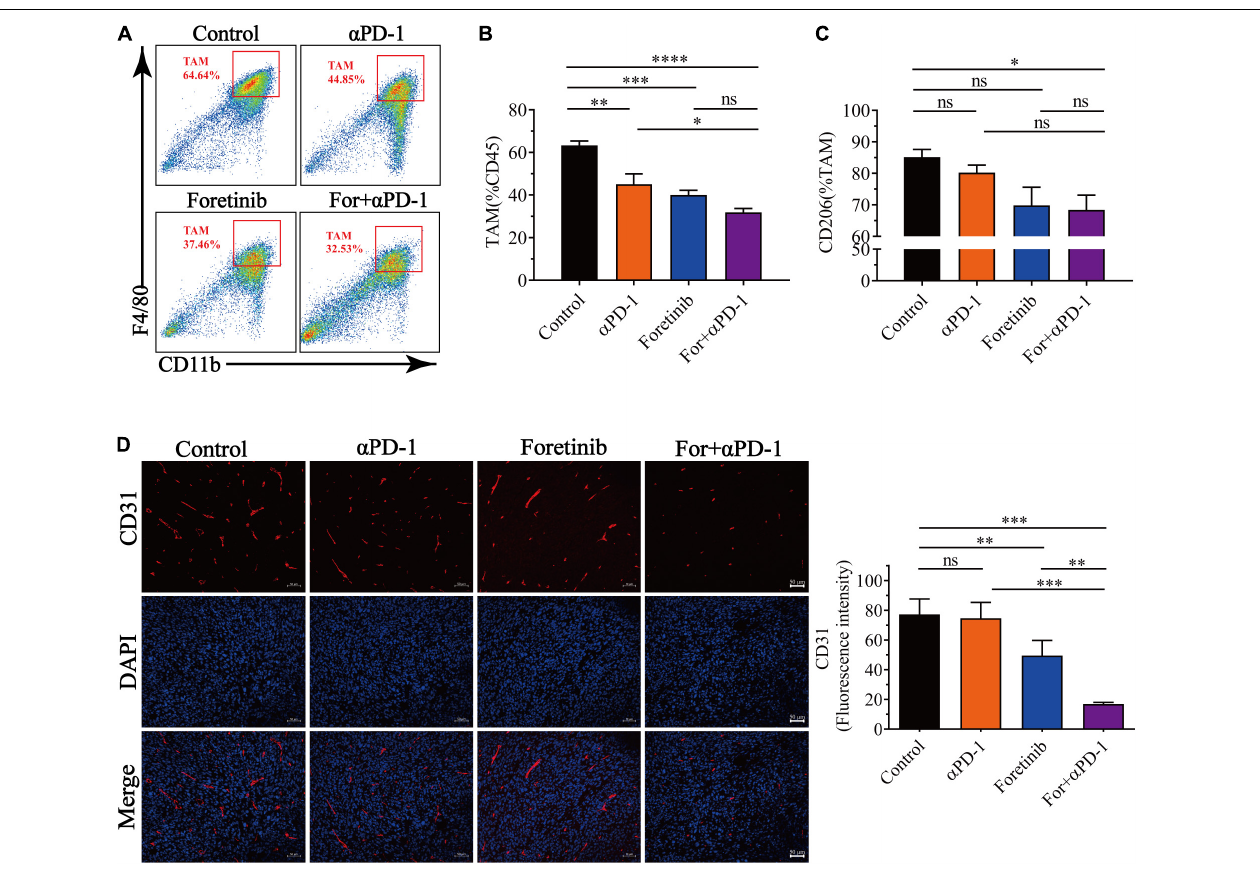
FIGURE 4 | Combination therapy decreased the number of TAM cells and inhibited angiogenesis. After finishing the treatment protocol, the tumor tissues were harvested and the TAMs and M2-type TAM infiltration was detected by FCM ( n = 6), angiogenesis (CD31+ cells) were detected by immunofluorescent ( n = 5). (A) Representative images of the gating strategy to defined TAMs. TAMs were characterized as being CD11b + F4/80 + . (B) Percentage of TAMs from each group. (C) Percentage of CD206 expression in TAMs from each group. (D) Representative immunofluorescent images for the CD31 (Red) and DAPI nuclear staining (Blue) from each group (left) and fluorescence intensity of CD31 (right) was quantified in the tumor tissues. Scale bar, 50 µ m. The data is presented using the mean ± SEM where applicable, * ( P ≤ 0.05), ** ( P ≤ 0.01), *** ( P < 0.001), **** ( P < 0.0001), and ns (no statistical significance, P ≥